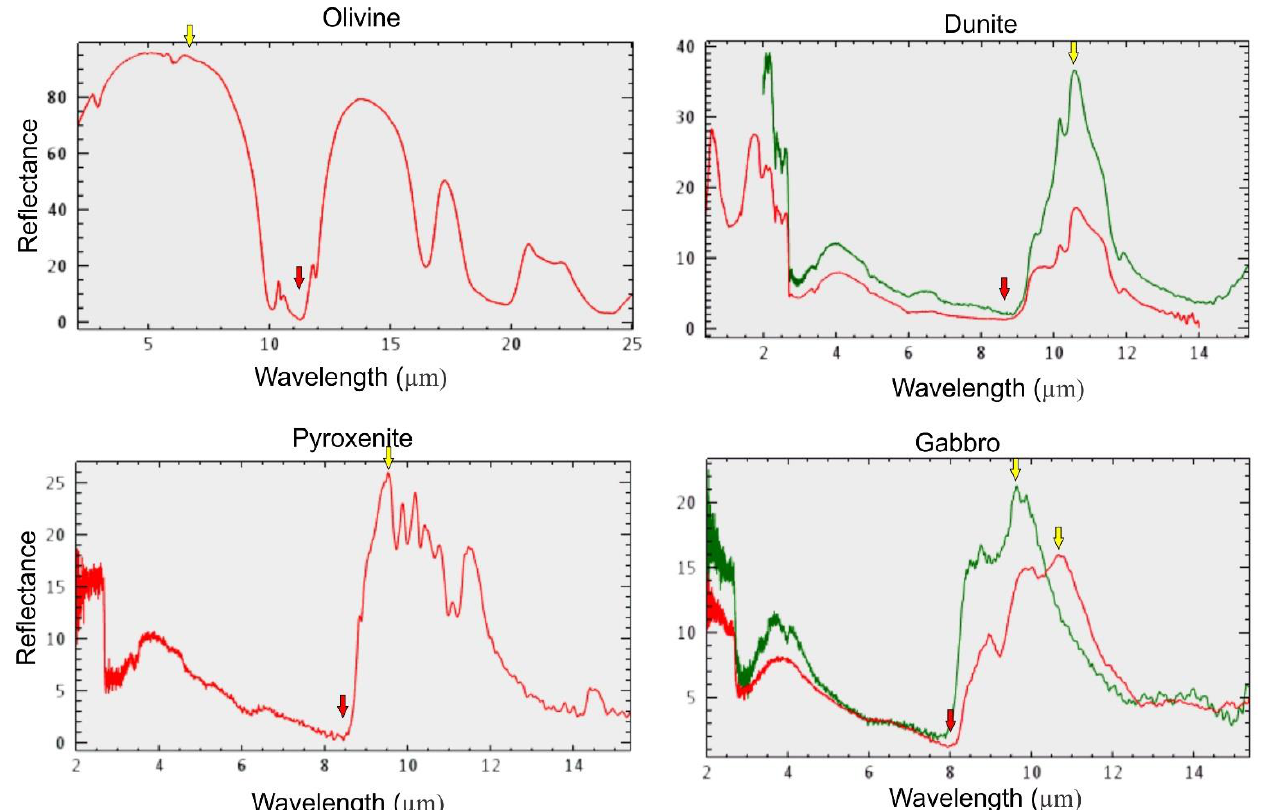
Figure 5. Spectra characteristics of mafic–ultramafic minerals (olivine) and rocks (dunite, pyroxenite, and gabbro) between 0.4–15 µm. The red arrows indicate the absorption and the yellow arrows show the reflectance/emissivity regions due to the composing materials.